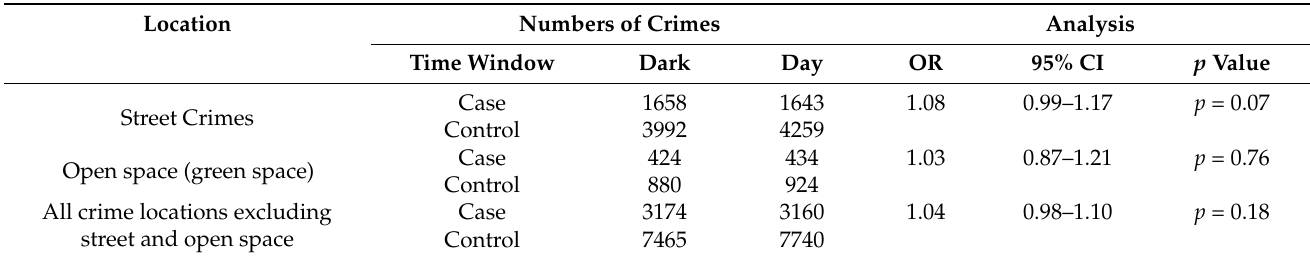
Table 5. ORs and 95% CIs associated with the change in crime frequency at dark compared to daylight for street crimes and non-street crimes. The associated p -values indicate whether the OR is significantly different to